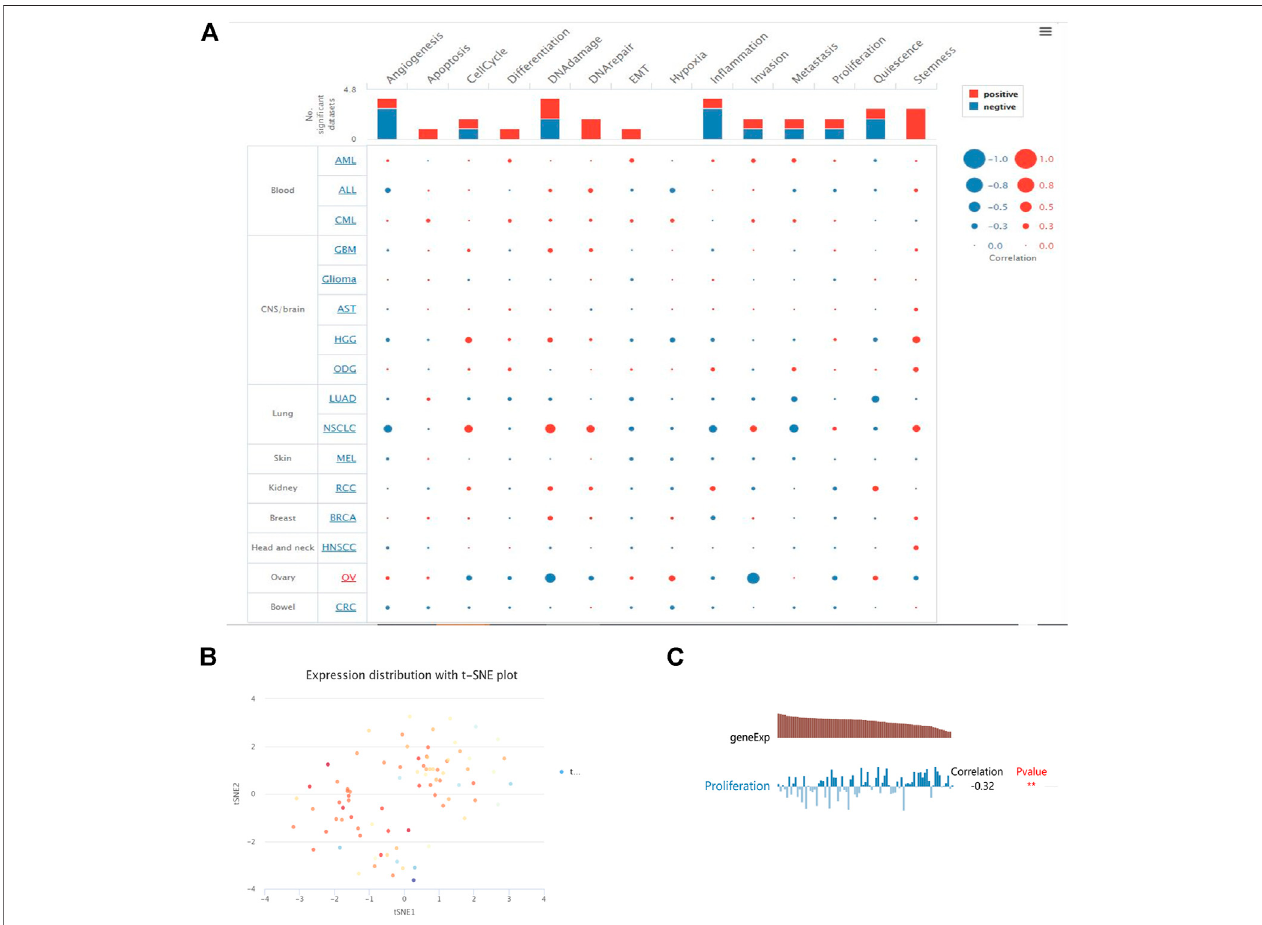
FIGURE 6 | YTHDF2 functional states in the scRNA-seq datasets. (A) Relevance of YTHDF2 across 14 functional states in distinct cancers. (B) The overall expression of the module in kidney clear carcinoma was found to be heterogeneous. (C) Correlations between the YTHDF2 expression and two functional states were identi fi ed by the CancerSEA database. * p < 0.05, **, p < 0.01, *** p <